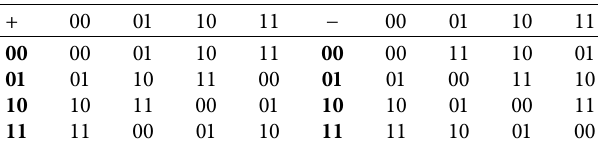
Figure 1: The phase diagram of the hyperchaotic system. Table 1: 32 cases in the 2-bit binary numbers addition and sub- traction